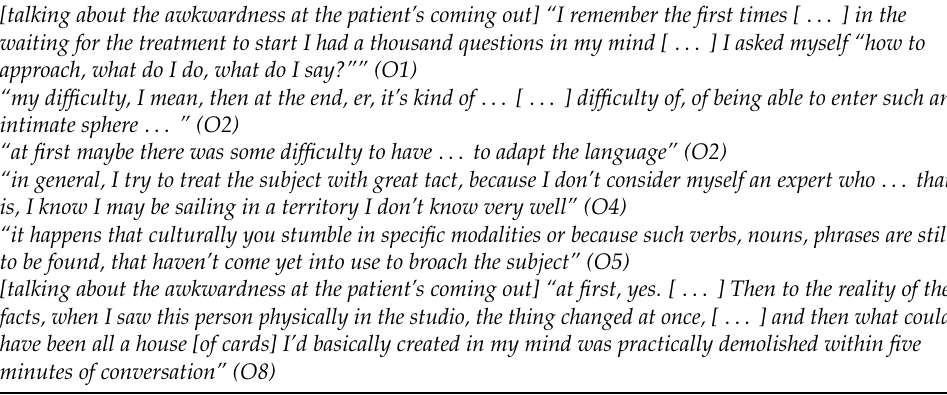
Table 12. Difficulty and awkwardness expressed by the practitioner.